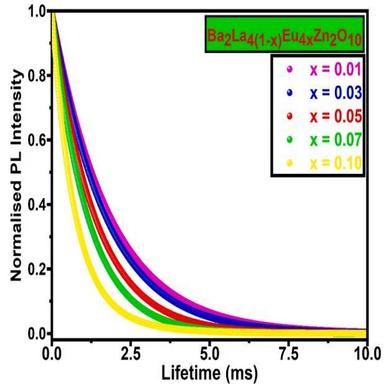
Lifetime decay curves of Eu3+ activated Ba2La4(1-x)Eu4xZn2O10 (x = 0.01–0.10) nanophosphor recorded at λex = 394 nm and λem = 620 nm.